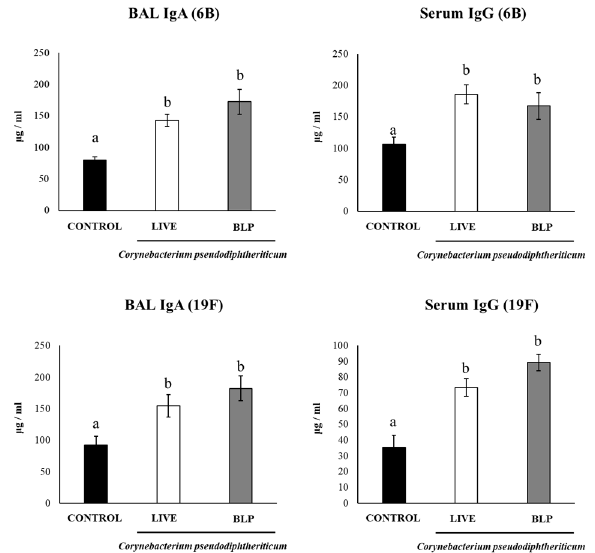
Figure 6. Resistance to Streptococcus pneumoniae infection induced by the immunization with the pneu- mococcal conjugate vaccine (PCV) plus Corynebacterium pseudodiphtheriticum 090104 or its bacterium- like particles (BLPs) in infant mice. Swiss albino infant mice (3 weeks old) were immunized by the nasal route with PCV or PCV plus C. pseudodiphtheriticum 090104 or it BLPs on days 0, 14, and 28. Five days after the last immunization (day 33), mice were nasally challenge with S. pneumoniae serotypes 6B or 19F. The determination of anti-pneumococcal IgA in broncho-alveolar lavage (BAL) samples and IgG in serum were performed on day 2 post-infection. Results represent data from three independent experiments ( n = 12) and are expressed as mean ± standard deviation. Letters indicate significant differences between the groups ( p <